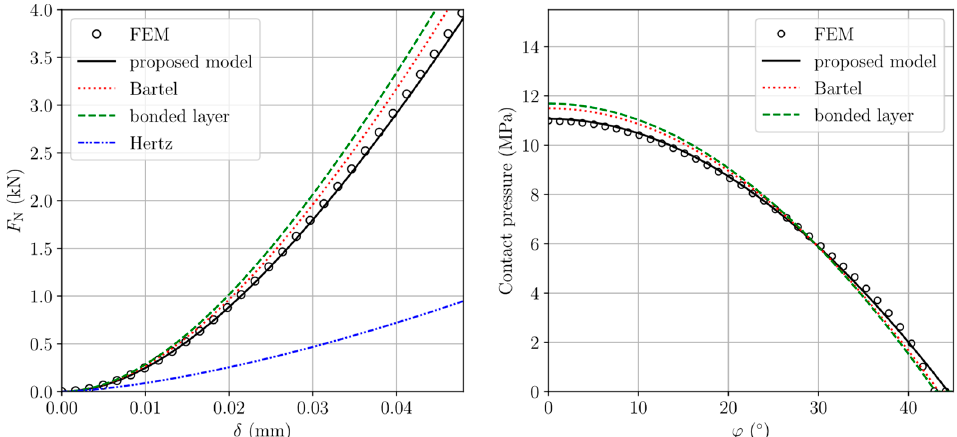
Figure 3. Comparison of the FEM solutions with Hertzian theory, Bartel’s analysis, results from the bonded-layer-model, and the new proposed model, respectively, for a Poisson’s ratio of 0.4, inner cup radius 18 mm, clearance 0.1 mm, and liner thickness 6.75 mm: normal force as a function of indentation depth ( left ), and pressure distribution as a function of angular coordinate for a normal force of 3000 N ( right ).